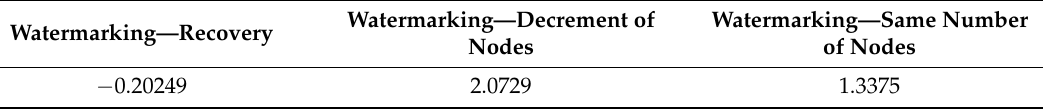
Table 5. The SNR values of the recovered speech signal with different numbers of nodes. Watermarking—Decrement of Watermarking—Same Number Watermarking—Recovery Nodes of Nodes